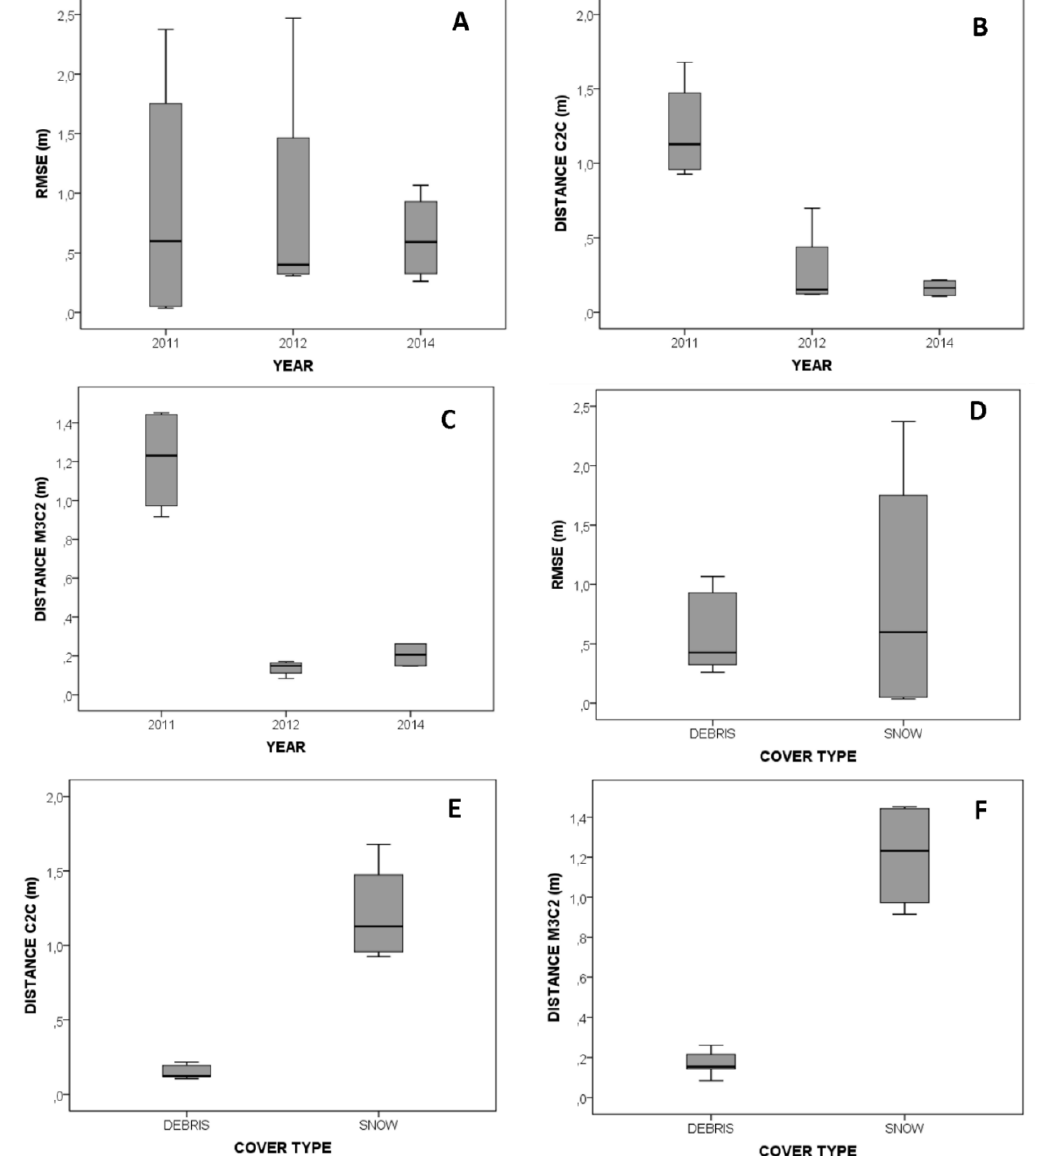
Figure 8. Box plot diagrams elaborated using the datasets showed in Table 2 and 3 and grouping these values according to the year of the capture and the cover type. The figure shows the ( A ) Root Mean Square Error (RMSE) obtained during the referencing procedure and grouped by year, ( B ) absolute average distance from the point clouds to the benchmark model estimated by the Cloud to Cloud (C2C) method and grouped by year, ( C ) absolute average distance from the point clouds to the benchmark model estimated by the Multiscale Model to Model (M3C2) method and grouped by year, ( D ) RMSE obtained during the referencing procedure and grouped by cover type, ( E ) absolute average distance from the point clouds the benchmark model estimated by the C2C method and grouped by cover type and ( F ) absolute average distance from the point clouds to the benchmark model estimated by the M3C2 method and grouped by cover type. Note that box plot diagrams show the maximum and the minimum values using the whiskers (upper and lower respectively), the interquartile range (the box) and the median (the line within the